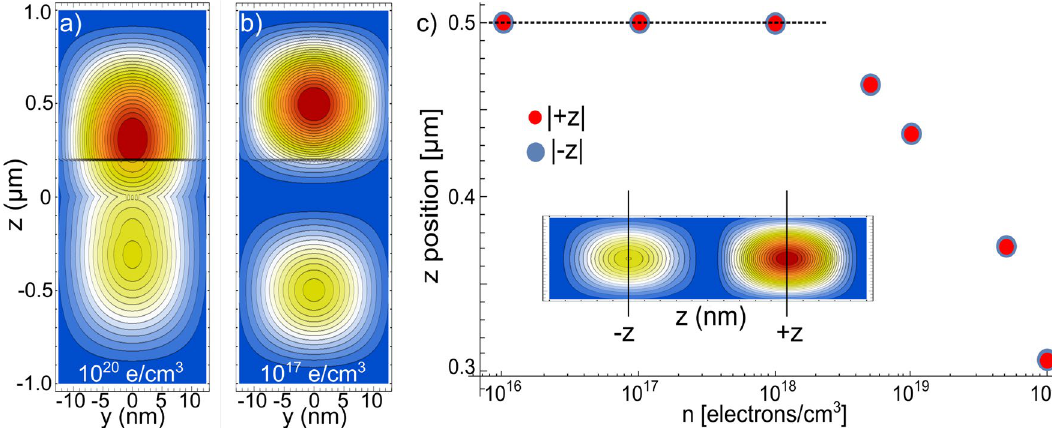
Figure 3. ( a ) y – z projections of the electron distribution probability corresponding to Fig. 2a. ( b ) y – z projections corresponding to Fig. 2c. ( c ) z -position of the left(blue)- and right(red)-central distributions, defined as schematized in the inset, for different n . When | ± z | = 0.5 , a Wigner-like molecule distribution is obtained.